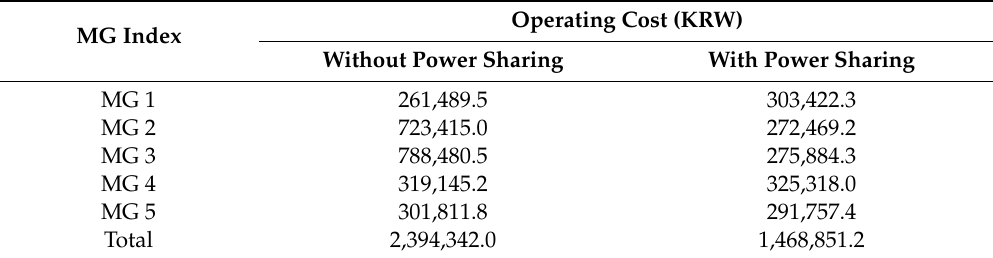
Table 3. Operating costs of the MGs with and without considering power sharing.